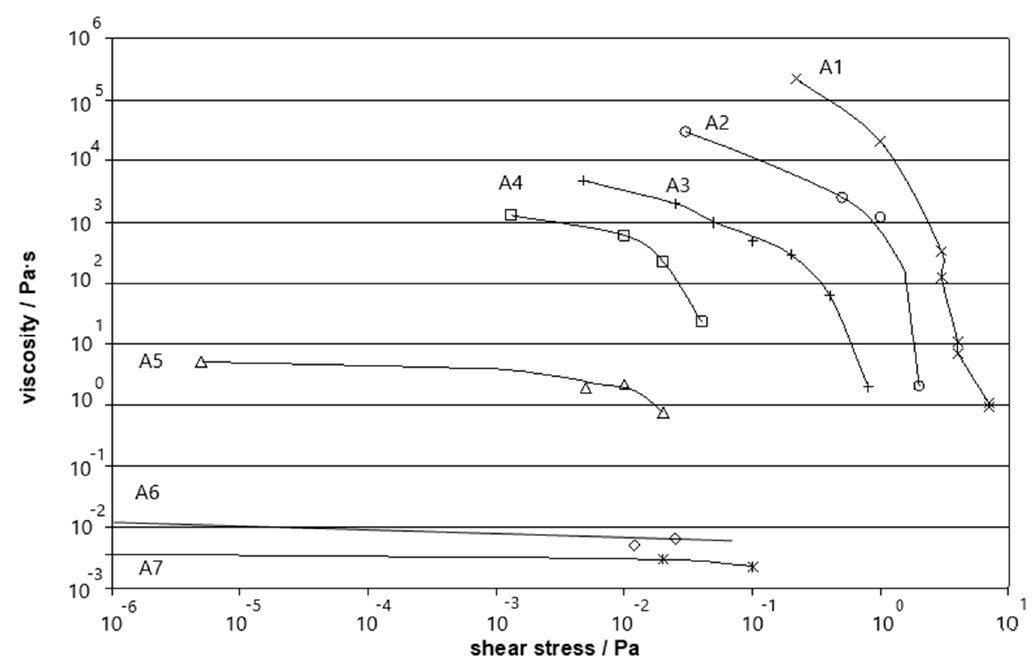
Figure 2. Viscosity / shear stress plots for Carbomer A at 15 ◦ C. Symbols refer to the fluids in Table Figure 2. Viscosity/shear stress plots for Carbomer A at 15 ° C. Symbols refer to the fluids in Table 1.